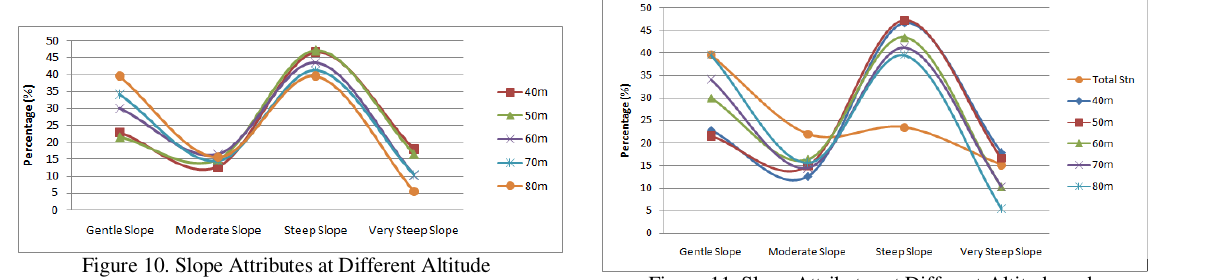
Figure 11. Slope Attributes at Different Altitude and Conventional Results (Total